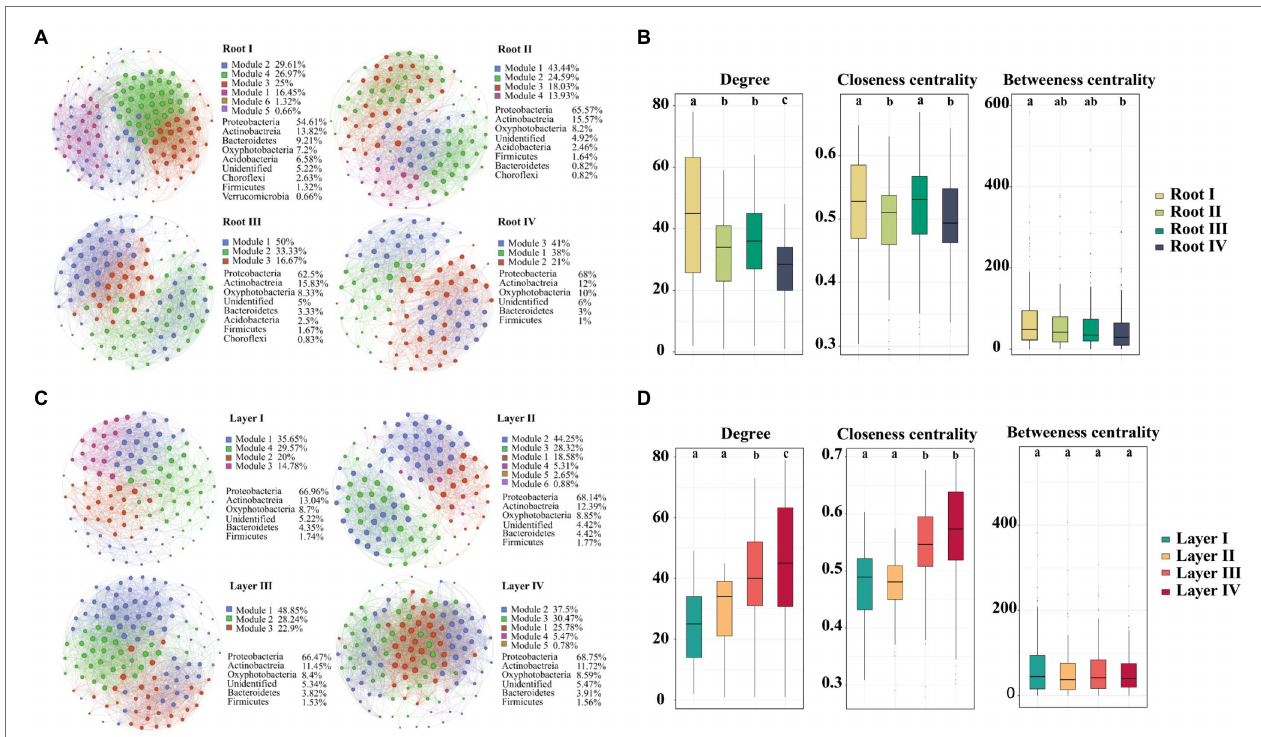
FIGURE 6 | An operational taxonomic unit (OTU) network map showing the composition and correlation of the OTUs in different root diameters (A) and rooting depths (C) . Network connections indicate a strong (Spearman’s ρ > 0.6) and significant ( p < 0.01) correlation. The size and color shade of each node is proportional to the number of connections (degree), and the thickness of each connection between two nodes (edge) is proportional to the value of Spearman’s correlation coefficients. Unique node-level topological features of bacteria of different root diameters (B) and rooting depths (D) , specifically the degree, betweenness, closeness. Different letters above the box indicate significant differences ( p < 0.05, multiple comparison with Kruskal-Wallis test).